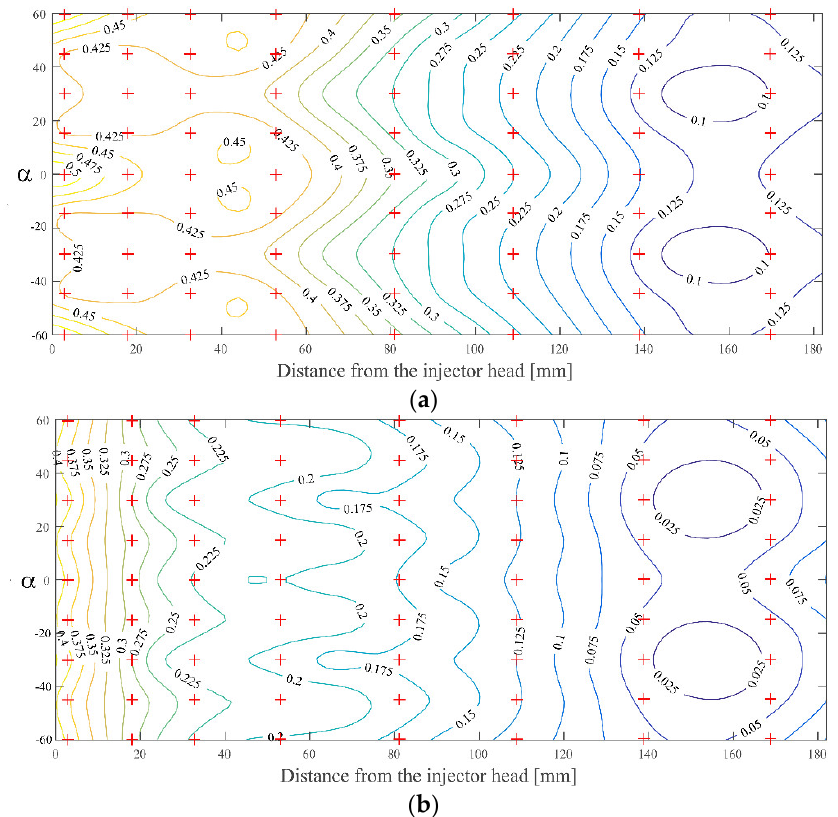
Figure 5. Distribution of cooling efficiency at different slot widths. ( a ) θ = 6.37°. ( b ) θ = 12.74°.